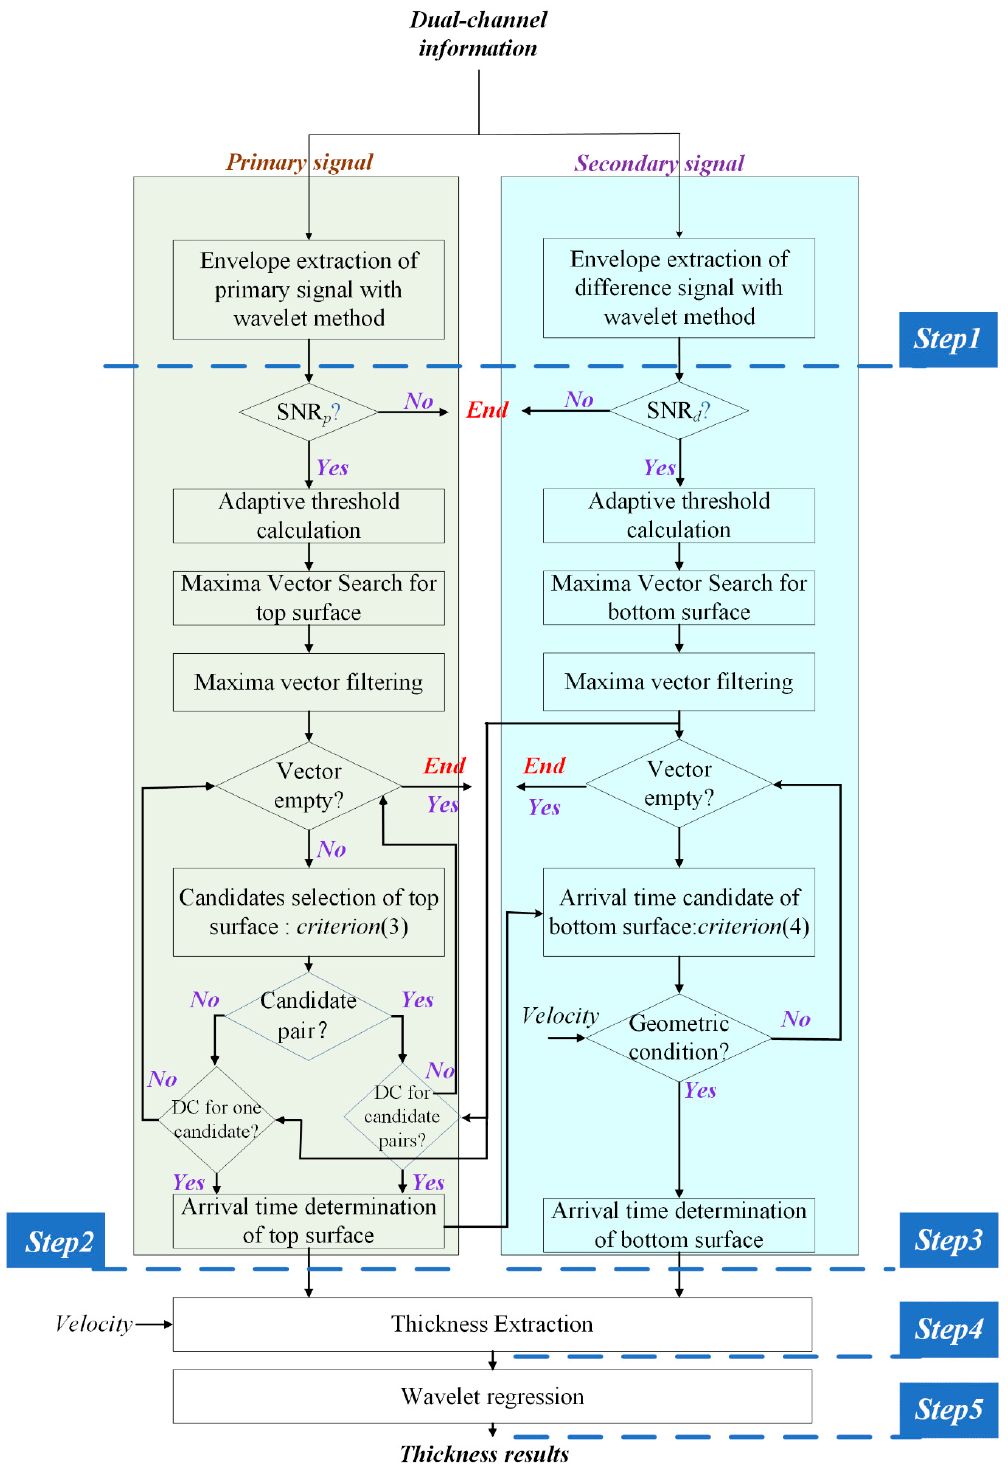
Figure 3. The flowchart of the processing